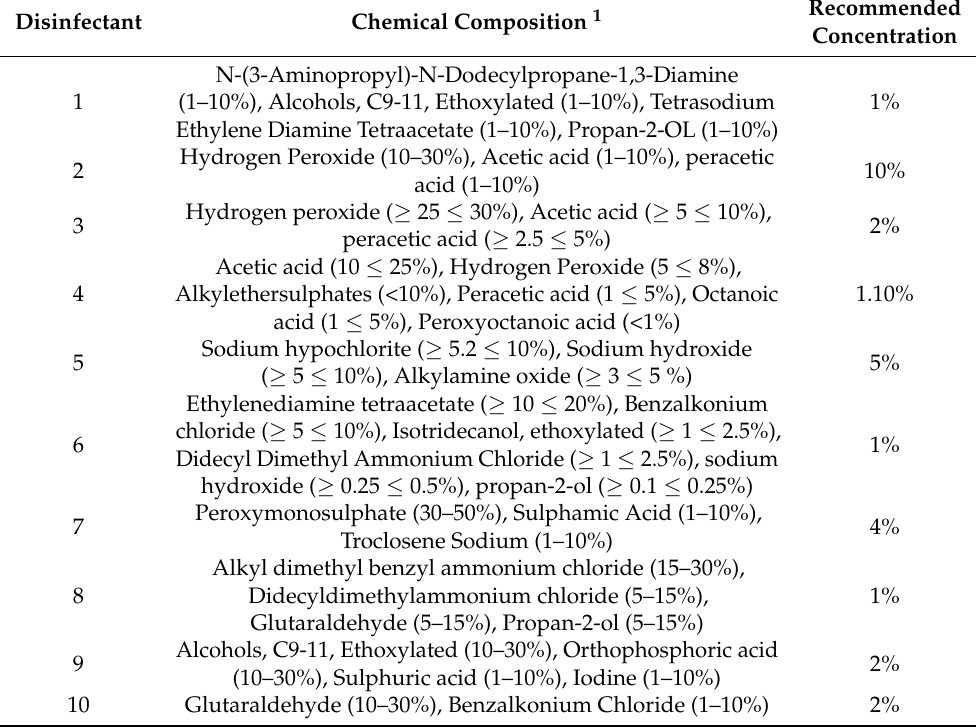
Table 1. Disinfectants used in the study.